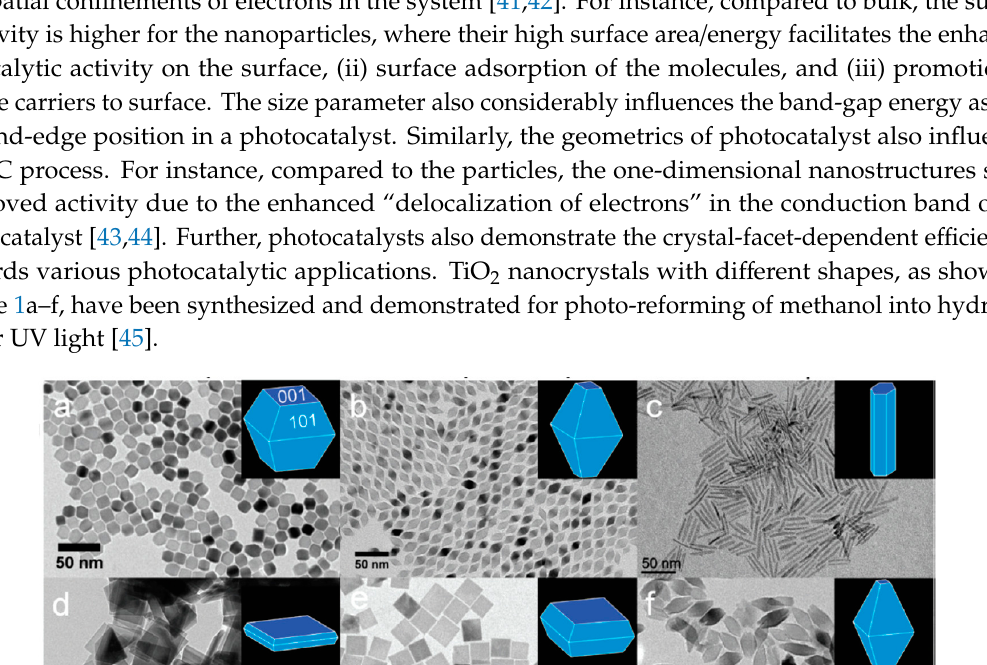
Figure 2. ( A ) Overall flowchart for fabrication of black hollow nanocubic (BHC)-TiO 2 ( a – p ), ( B ) Comparison photocatalytic activity of different TiO 2 nanostructures in the synthesis of benzimidazole under UV and visible conditions; ( C ) Schematic diagram of the light scattering effect caused by BHC- TiO 2 nanocubes ( a ) and schematic of the proposed mechanism for benzimidazole preparation by BHC-TiO 2 architecture ( b ) (reproduced with permission from ref. [46]). 3.2. Doped TiO 2 Doping can be essentially classified into two categories, (i) cationic and (ii) anionic doping. Accordingly, TiO 2 has been widely modified through doping under both categories. The cationic and anionic doping in TiO 2 leads to the formation of new energy levels underneath the conduction band and above the valence band [54]. The former doping has often been found to reduce the band gap energy and facilitates the visible light absorption and charge separation in TiO 2 , whereas the latter often helps in shifting of the VB position, mitigates the defects, and enhances the chemical stability of TiO 2 [55]. The anionic dopants such as N, C, S, and P have been largely doped in TiO 2 . Among them, the N doping showed relatively enhanced photocatalytic activity due to the increased stability in the system. Similarly, there are variety of elements doped at the cationic site of TiO 2 and explored for their photocatalytic activities under UV-visible light.